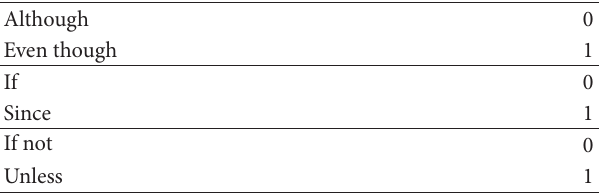
Table 4: Synonym substitution for conditional